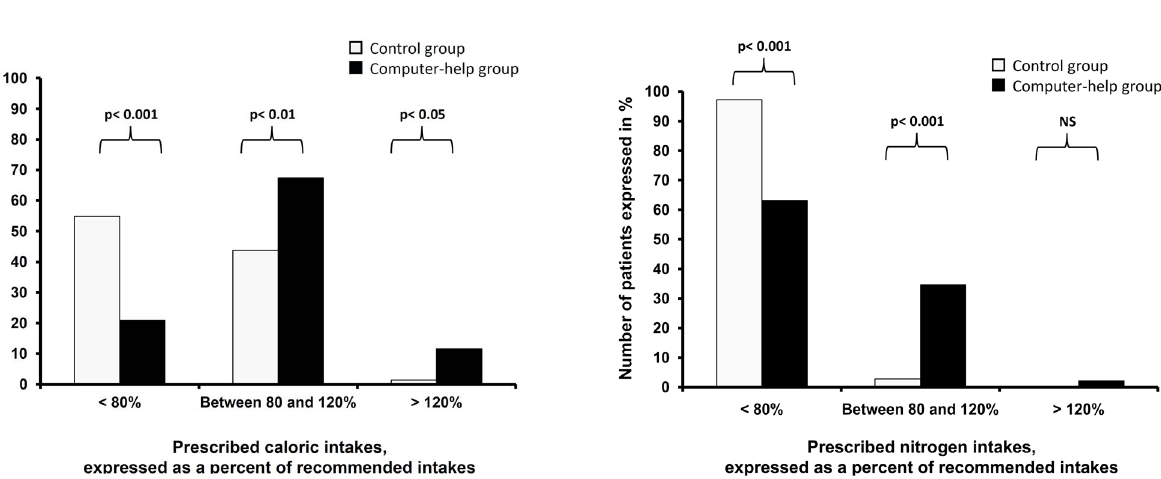
Figure 4. Nitrogen intake prescribed before and after imple- mentation of the computer help expressed in percent of recommended goals for artificial nutrition. Introducing the computer help was associated with a significant increase in the number of patients whose prescribed nitrogen intake was at least 80% of recommended